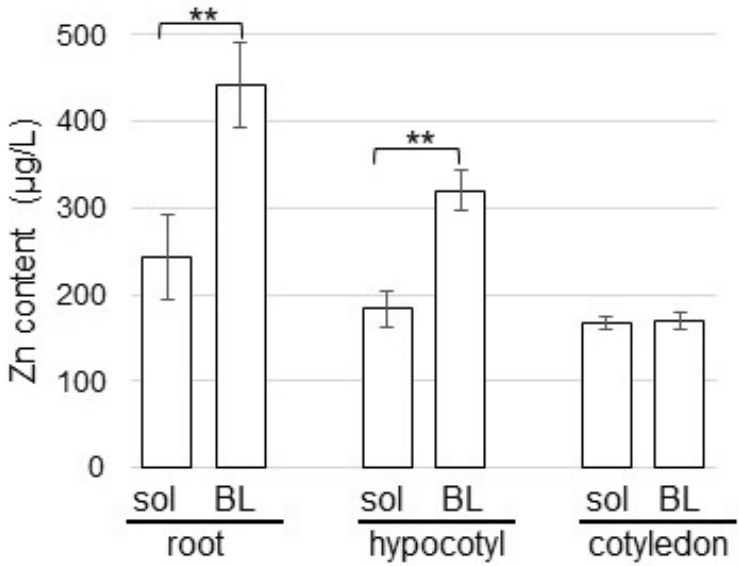
Figure 2. Effects of ZnO NPs on the Zn content in soybean seedlings. Silica sand was treated with 1 ppm ZnO NPs with 200 nm (sol) and 1 ppm BL-fiber crosslinked with ZnO NPs with 200 nm (BL). After sowing, root, hypocotyl, and cotyledon were collected from four-day-old soybeans and the Zn content was measured. Data are presented as the mean ± S.D. from three independent biological replicates. Asterisks indicate significant changes between the two treatments according to Student’s t -test (** p < 0.01).